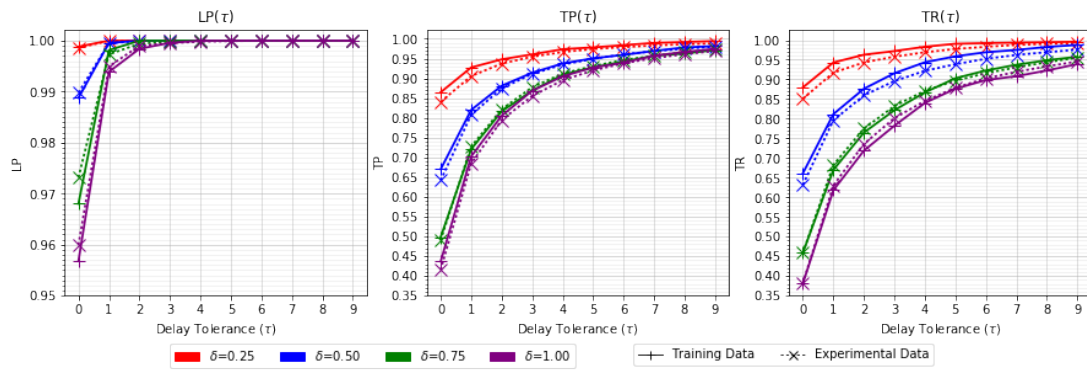
Figure 6. Case study II. LP, TP, and TR metrics for training and experimental data.